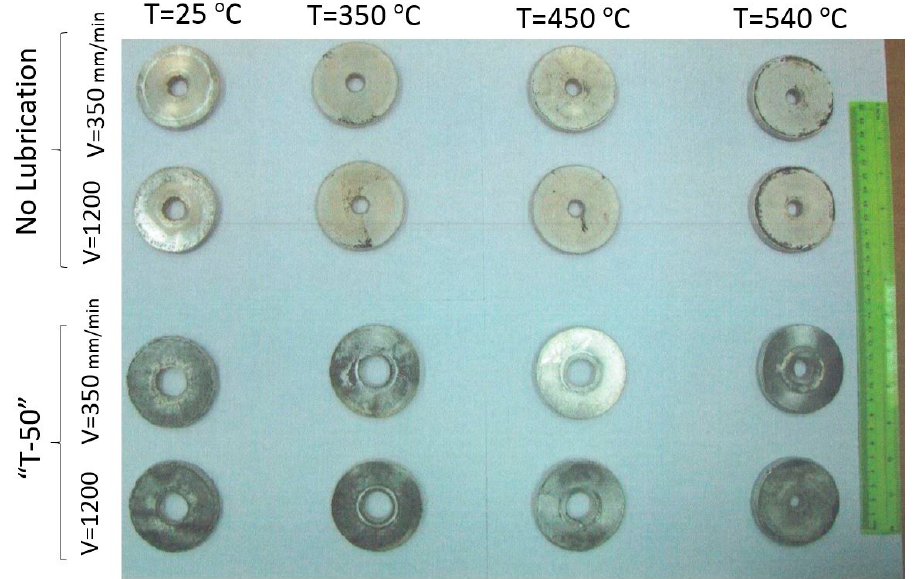
Figure 8. An upper view of the Al1050 rings after upsetting.